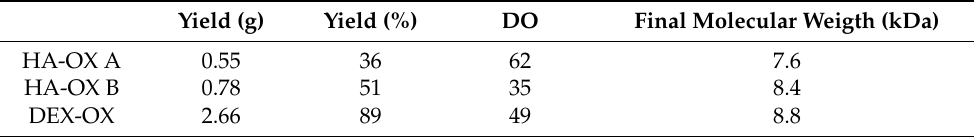
Table 3. Characterisation of oxidized